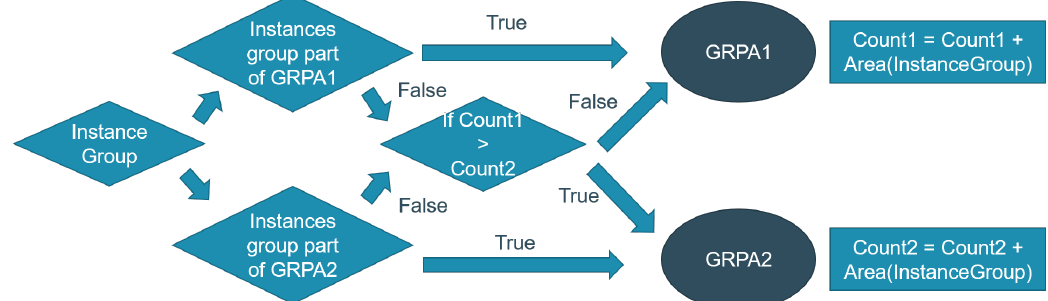
Figure 3. Segmentation algorithm: Triple Modular Redundancy (TMR) datapaths are balanced between 2 Groups representing the floorplan groups ABC1 and